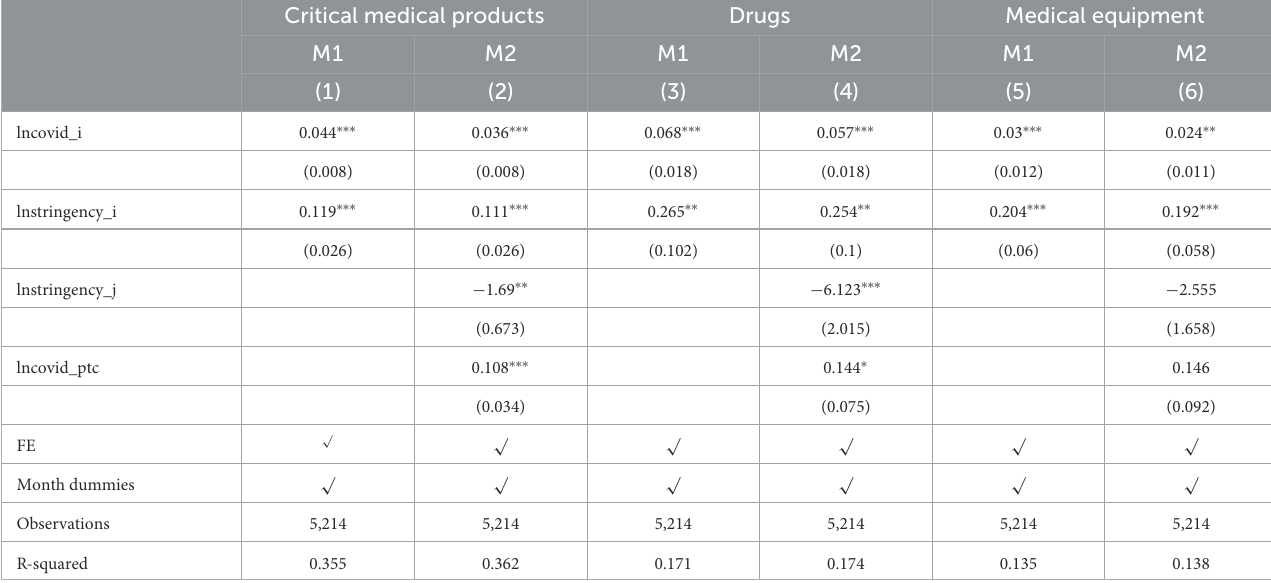
TABLE 1 Baseline